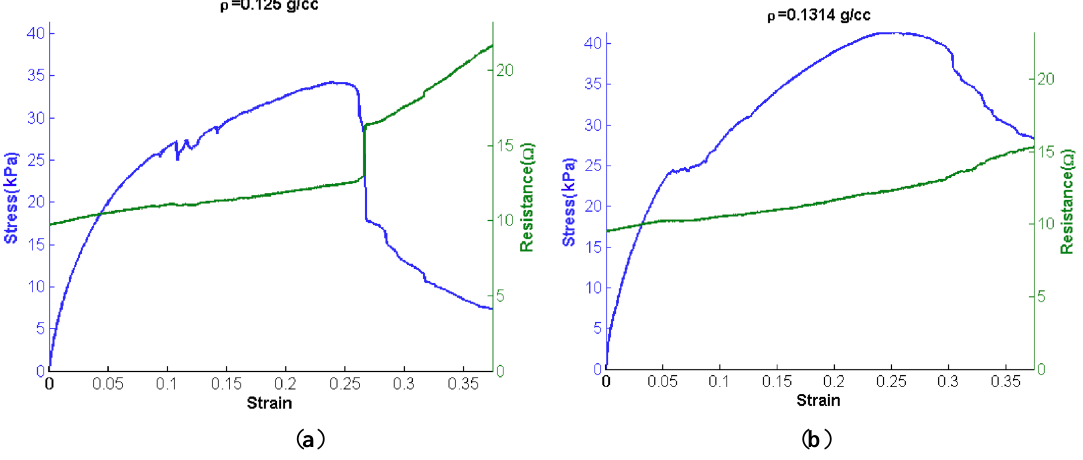
Figure 2. Tensile behavior of carbon nanofiber network under tension, accompanied by resistance measurements as a function of strain (mm/mm). ( a ) Low density network; ( b ) High density